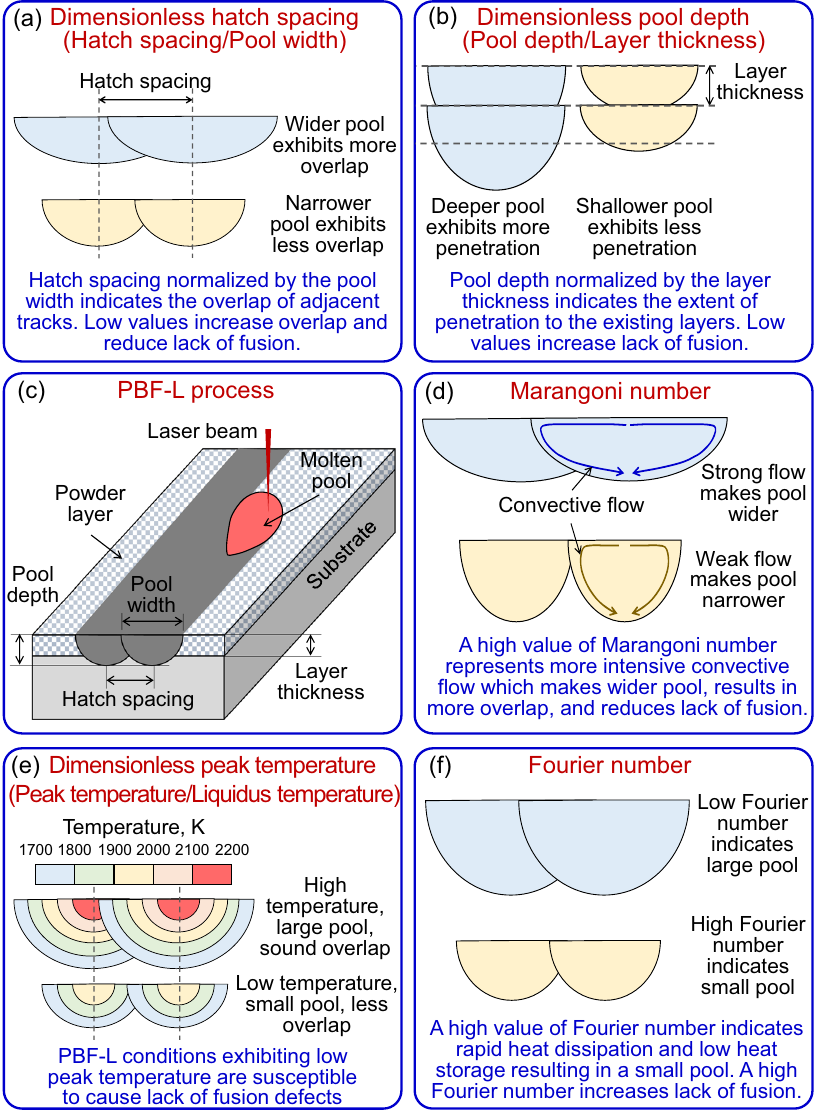
Fig. 2 The fi ve mechanistic variables and their effects on the lack of fusion defect in PBF-L parts. a Dimensionless hatch spacing is represented by the ratio of hatch spacing to pool width. b Dimensionless pool depth is a ratio of pool depth to layer thickness. Figures a and b show that the lower dimensionless hatch spacing and higher dimensionless pool depth can reduce the lack of fusion. Figure c shows the schematic diagram of the PBF-L process. d Marangoni number indicates the intensity of the convective fl ow of liquid metal inside the molten pool. A high Marangoni number representing a vigorous fl ow of liquid metal can reduce the lack of fusion defects. e The dimensionless peak temperature is represented by the ratio of the peak temperature to the liquidus temperature of the alloy. f Fourier number indicates the ratio of the rate of heat dissipation to the rate of heat storage. Figures d and e show that a low Fourier number and a high dimensionless peak temperature can reduce the lack of fusion